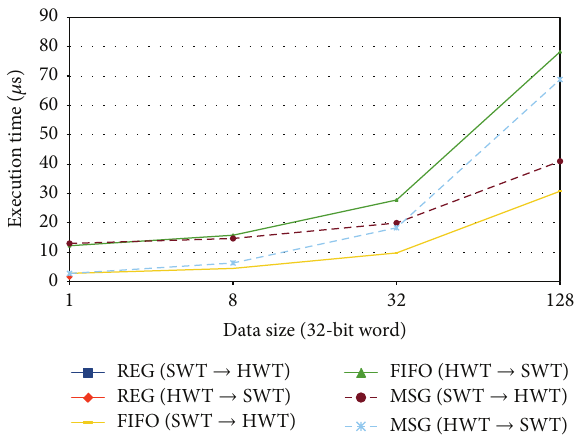
Figure 23: SW-HW communication times for different sizes of data (HWT @ 100MHz).